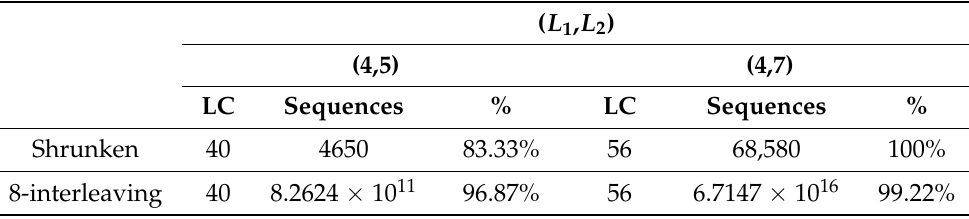
Table A5. Comparison between number of shrunken sequences and 8-interleaving sequences with maximum LC